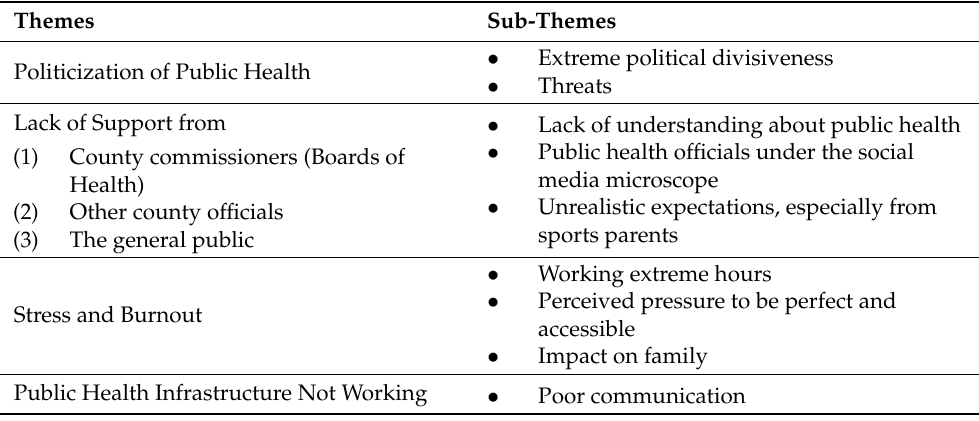
Table 2. Themes and